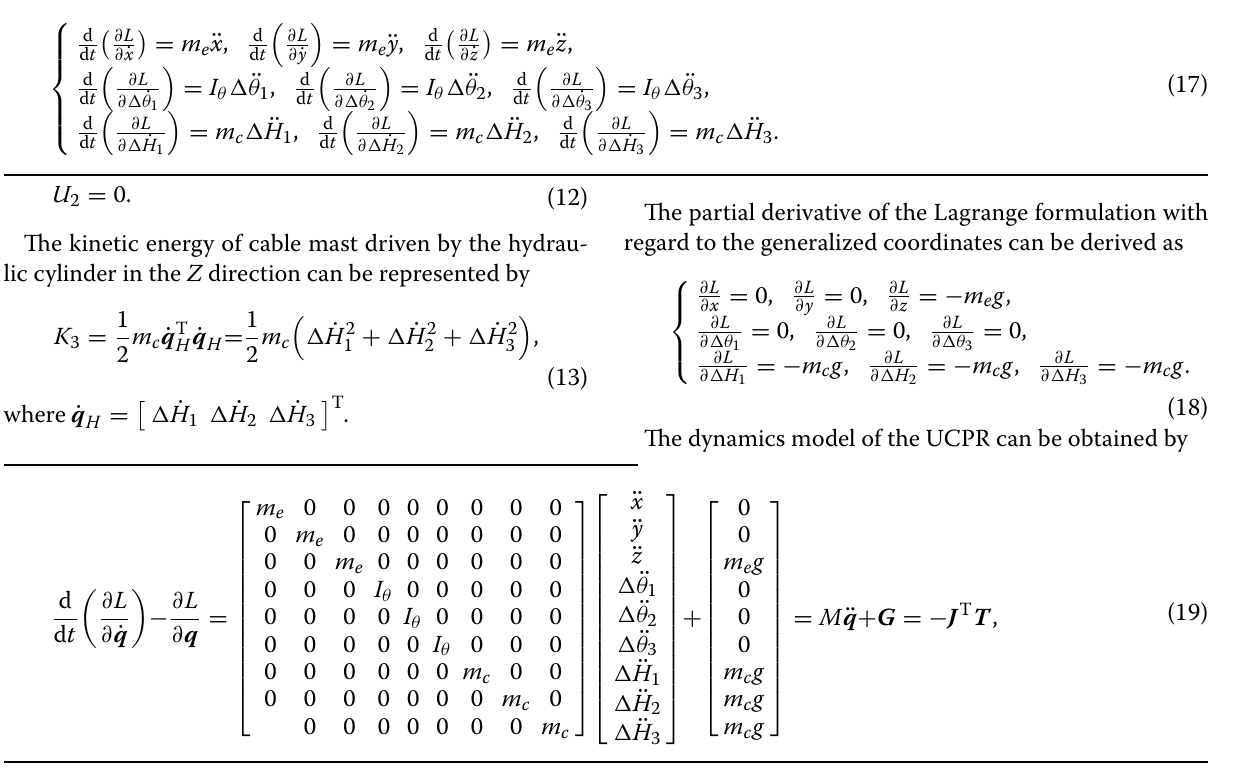
resents the generalized force of the UCPR. Substituting Eq. (15) into Eq. (16) leads to